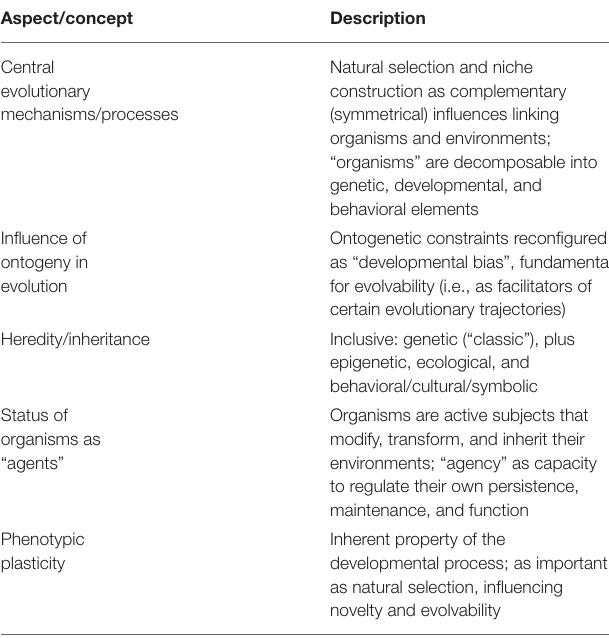
TABLE 1 | Recent progress in evolutionary biology originated from evo-devo, eco-evo-devo, and the “Extended Evolutionary Synthesis” (EES).